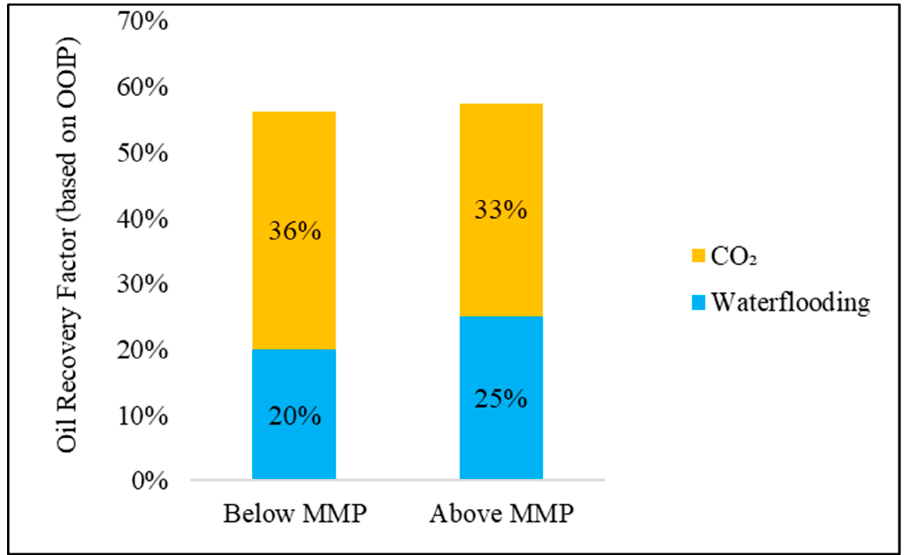
Figure 17. Oil recovery results from Clinton sandstone coreflooding tests.